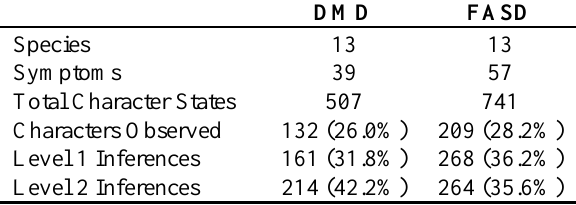
Table 1. Summary of documented and inferred